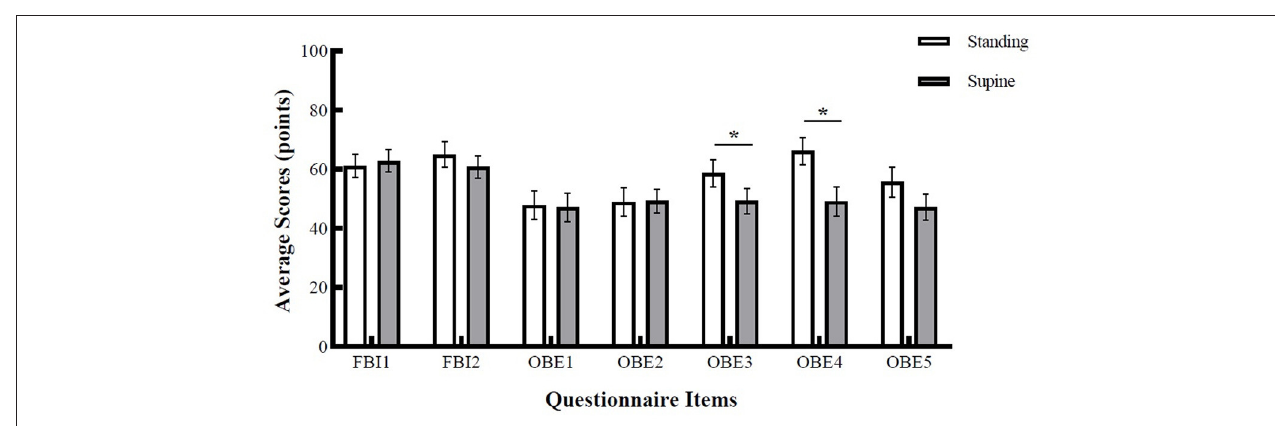
Frontiers in Integrative Neuroscience |